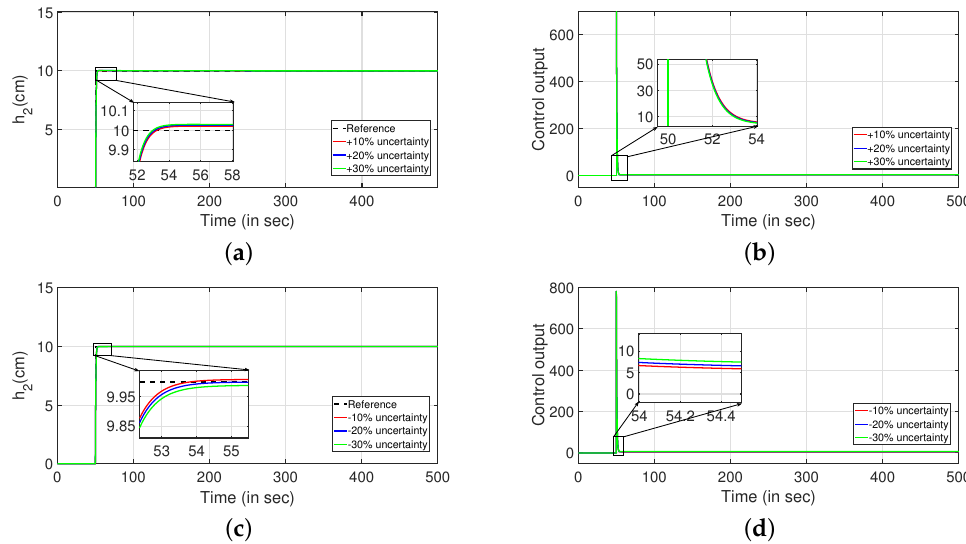
Figure 26. Reference tracking of Equation (50) for ± 10%, ± 20% and ± 30% uncertainties. ( a ) Level Variation in tank 2. ( b ) Control output. ( c ) Level Variation in tank 2. ( d ) Control